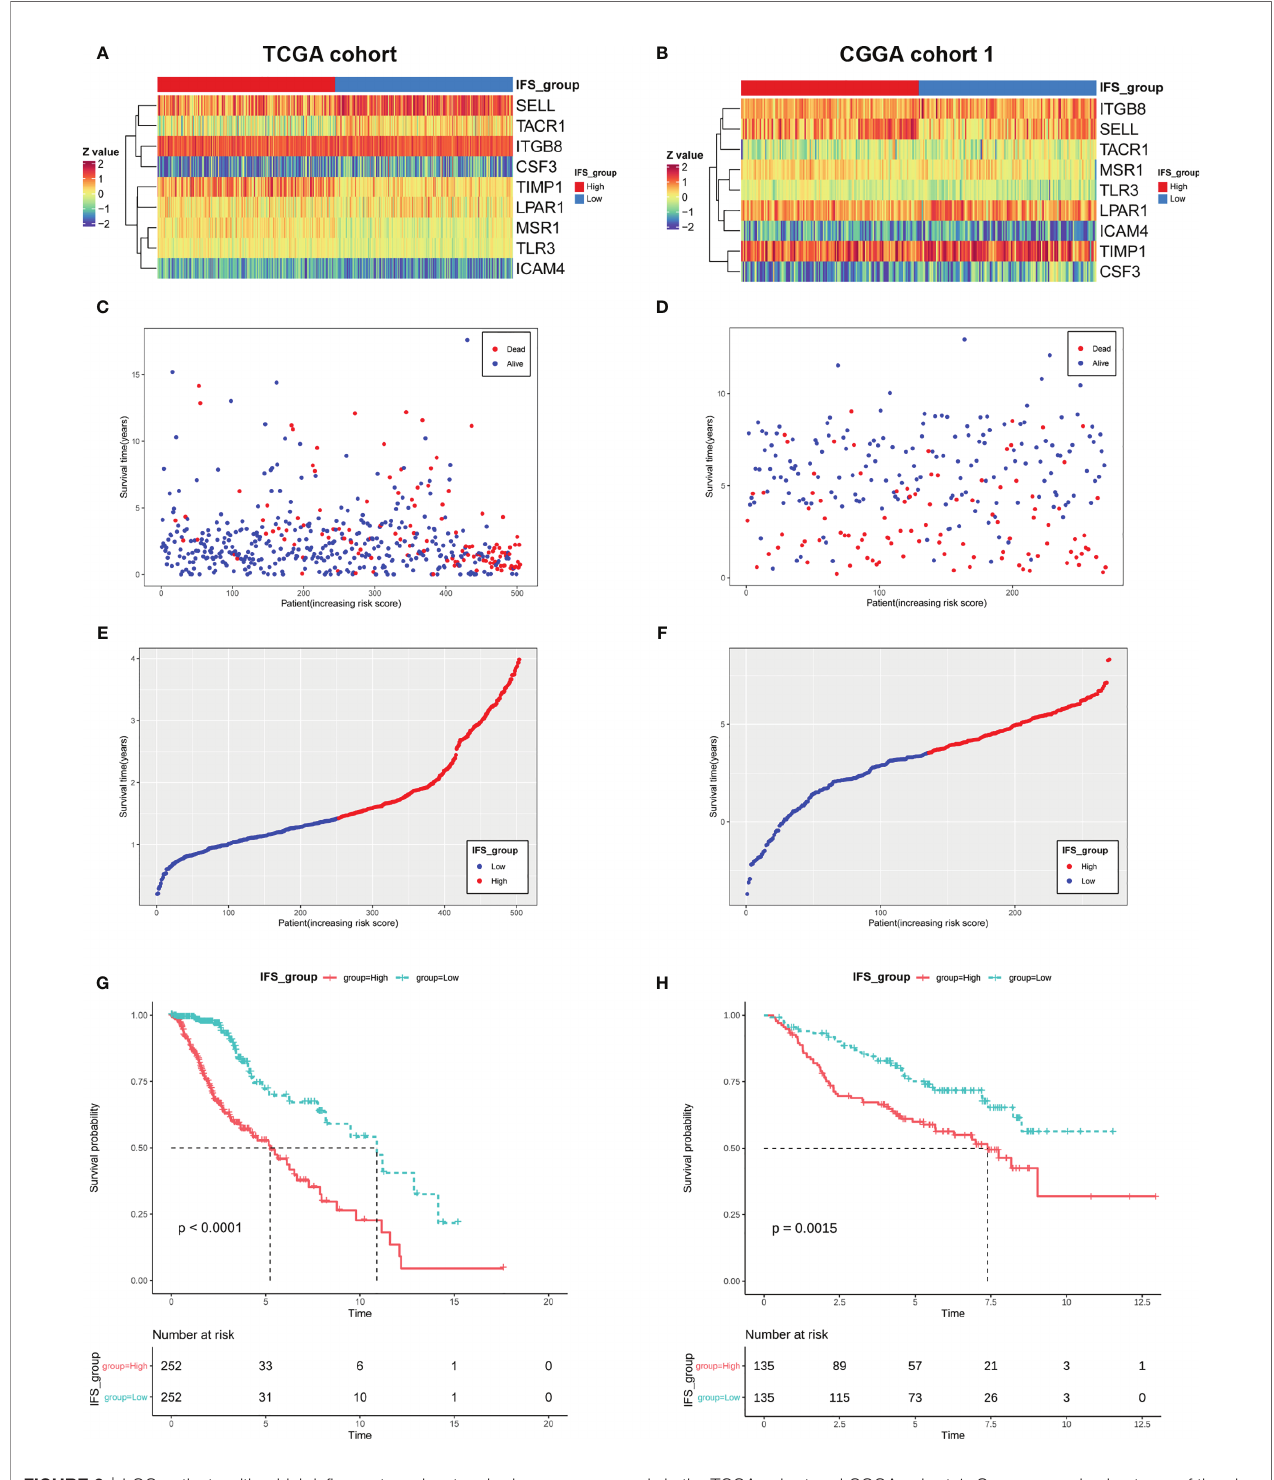
FIGURE 3 | LGG patients with a high in fl ammatory signature had a worse prognosis in the TCGA cohort and CGGA cohort 1. Gene expression heatmap of the nine in fl ammation-related genes with prognostic signi fi cance in the TCGA cohort (A) and CGGA cohort 1 (B) . Survival status diagram of LGG patients in the TCGA cohort (C) and CGGA cohort 1 (D) (red dots represent death, and blue dots represent survival). Score distribution diagram of LGG patients with high- or low-in fl ammatory signature groups in the TCGA cohort (E) and CGGA cohort 1 (F) (red: high IFS; blue: low IFS). Survival curve for LGG patients with high- or low-in fl ammatory signature groups in the TCGA cohort (G) and CGGA cohort 1 (H)